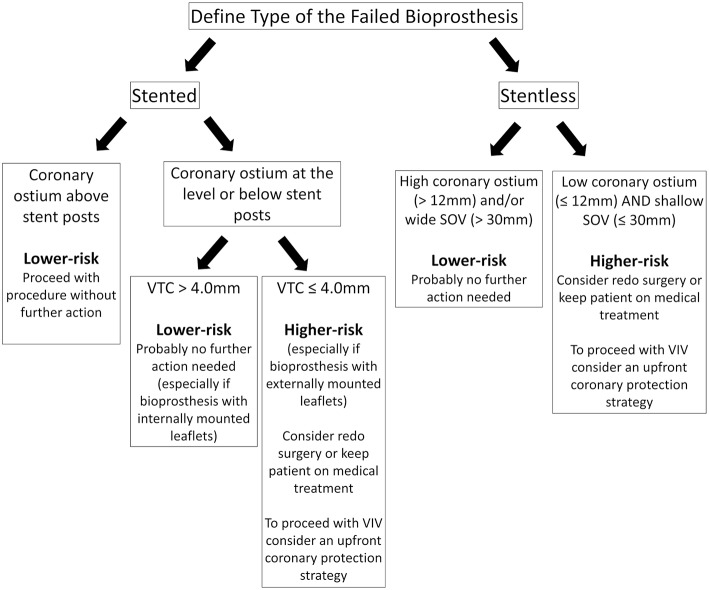
Suggested pre-procedural risk assessment algorithm for coronary obstruction in patients undergoing VIV.